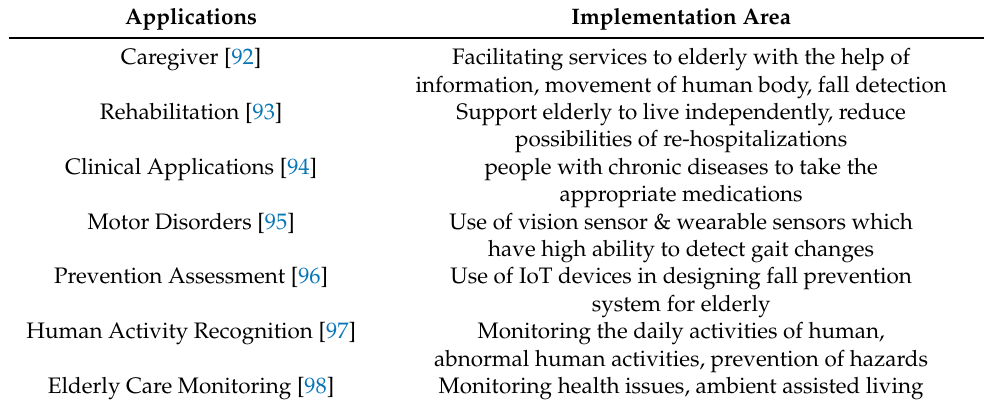
Table 3. Robotic applications in service